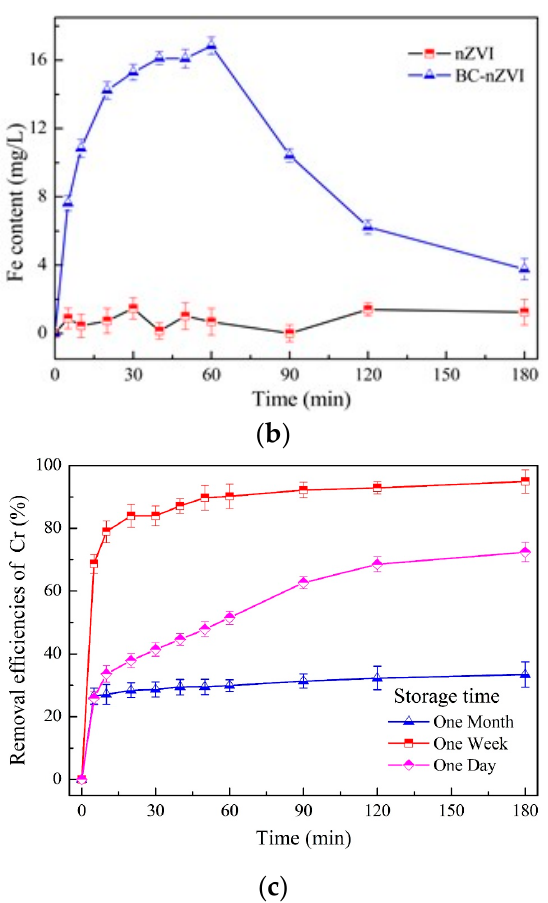
Figure 4. Comparative removal efficiencies of total Cr using different materials. ( a ) BC, nZVI, and BC-nZVI; ( b ) Change of iron content in solution; ( c ) BC-nZVtI with different storage time.